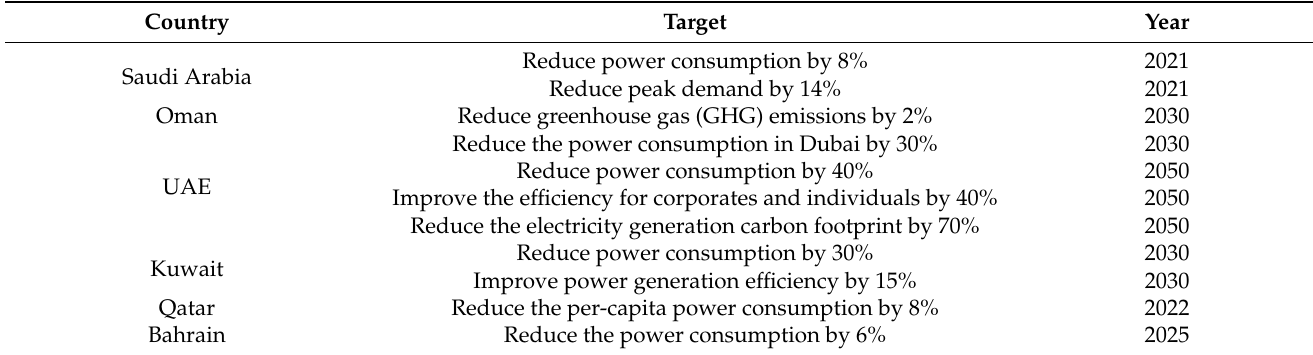
Table 2. GCC future target to reduce CO 2 emissions